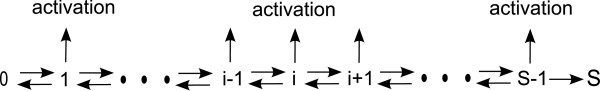
Markov diagram for the probability of number of Cdc20 molecules. Cdc20 at state k is generated and destroyed at rate λ(S -- k) and k-1k respectively. Diffusing Cdc20 molecules bind to the APC/C complex to trigger the separation of sister chromatids.